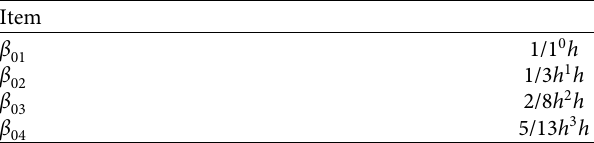
Table 1: Parameter